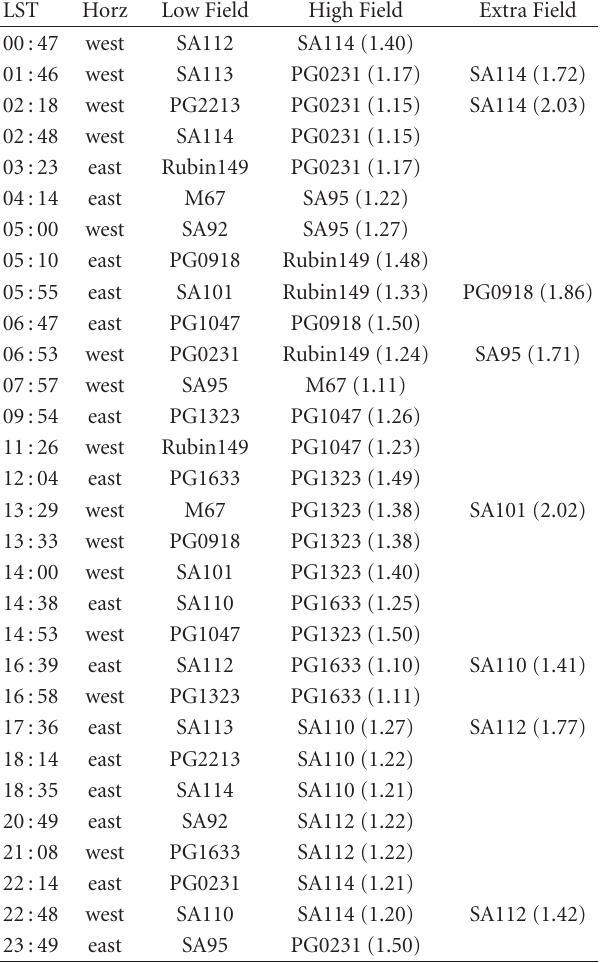
Table 2: Standard star observing